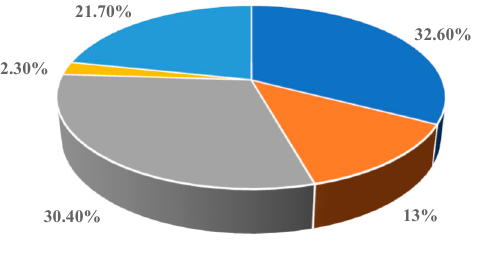
Figure 3. The frequency of witnessing dangerous situations at crosswalks.